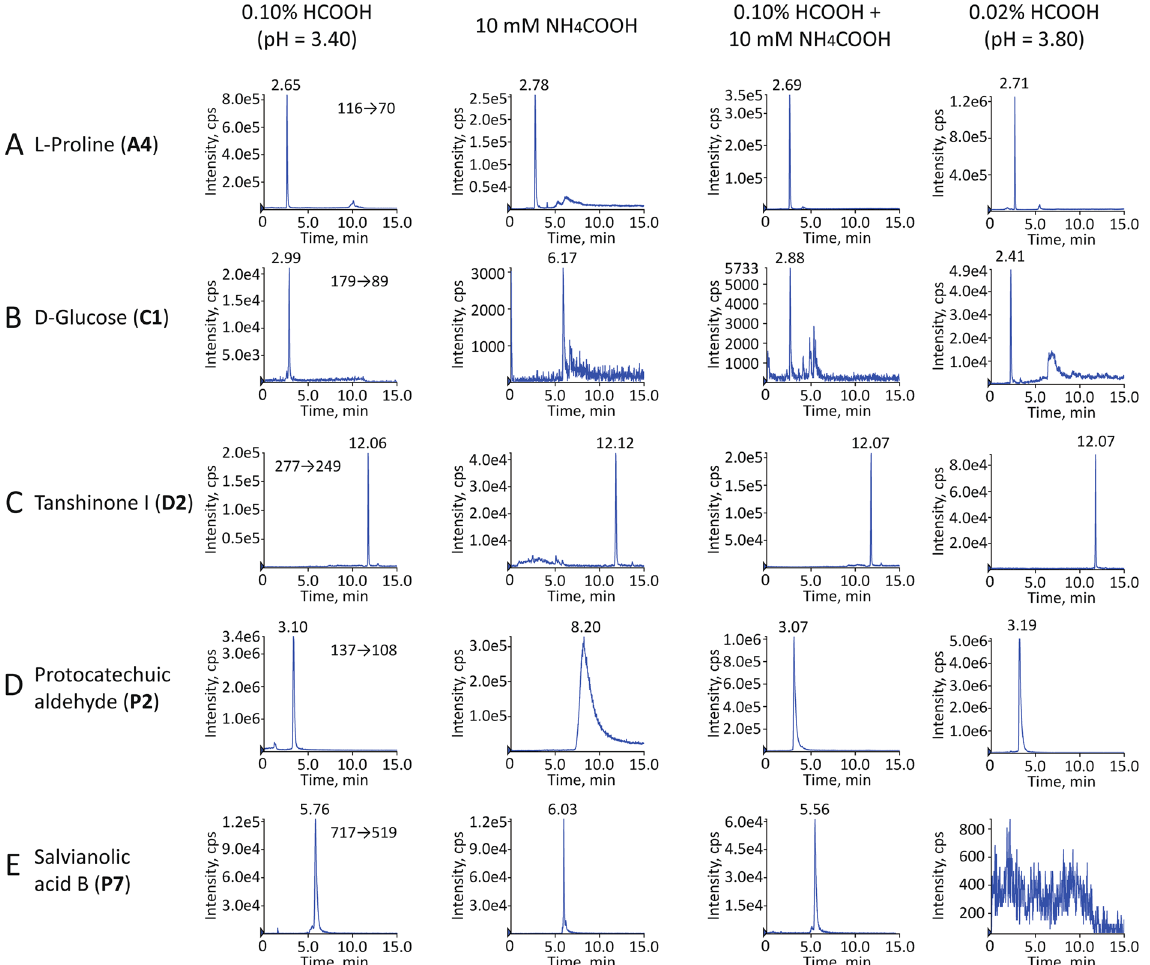
Figure 4. MRM chromatograms of L-proline ( A ), D-glucose ( B ), tanshinone I ( C ), protocatechuic aldehyde ( D ), and salvianolic acid B ( E ) using directly-coupled RP-HILIC-MS/MS analysis with different acidic additives (0.1% HCOOC, 10 mM NH 4 COOH, 0.1% HCOOH combined with 10 mM NH 4 COOH, and 0.02% HCOOH) in the mobile